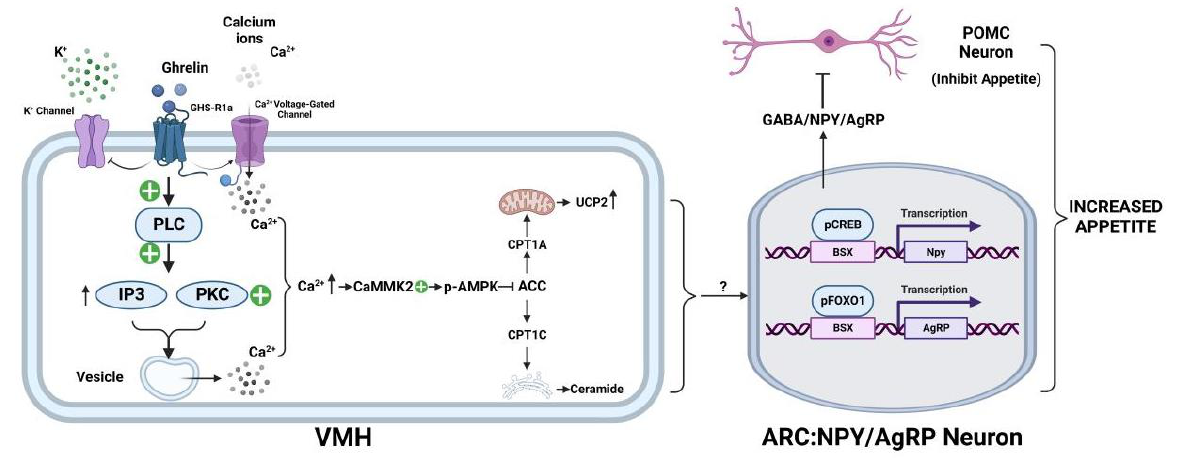
Figure 2. Ghrelin downstream signaling pathways in VMH and ARC. By activating intracellular downstream signaling molecules and promoting neurotransmitter transmission, ghrelin eventually promotes appetite. VMH, ventromedial nucleus of the hypothalamus; ARC, arcuate nucleus; PLC, phospholipase C; IP3, inositol triphosphate; PKC, protein kinase C; CaMKK2, calcium-dependent protein kinase kinase 2; MAPK, mitogen-activated protein kinase; CREB, cAMP-response element binding protein; FOXO1, Forkhead Box O1; BSX, brain-specific homeobox transcription factor; Npy, Neuropeptide Y; AgRP, agouti-related protein; GABA, γ -aminobutyric acid; POMC, pro-opiomelanocortin. Created with BioRender.com.